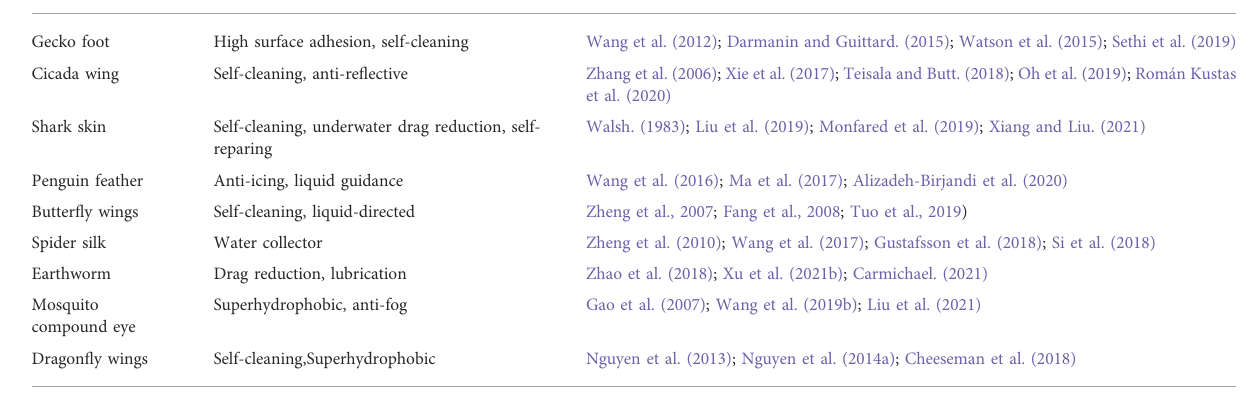
TABLE 5 The surface structures of typical animals.